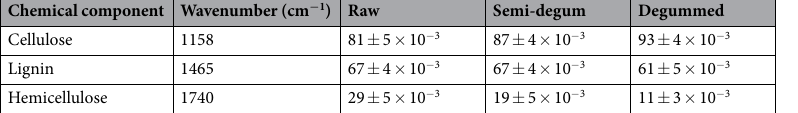
Table 2. Mean absorbance on the surface of kenaf fiber for cellulose, hemicellulose and lignin in different samples.